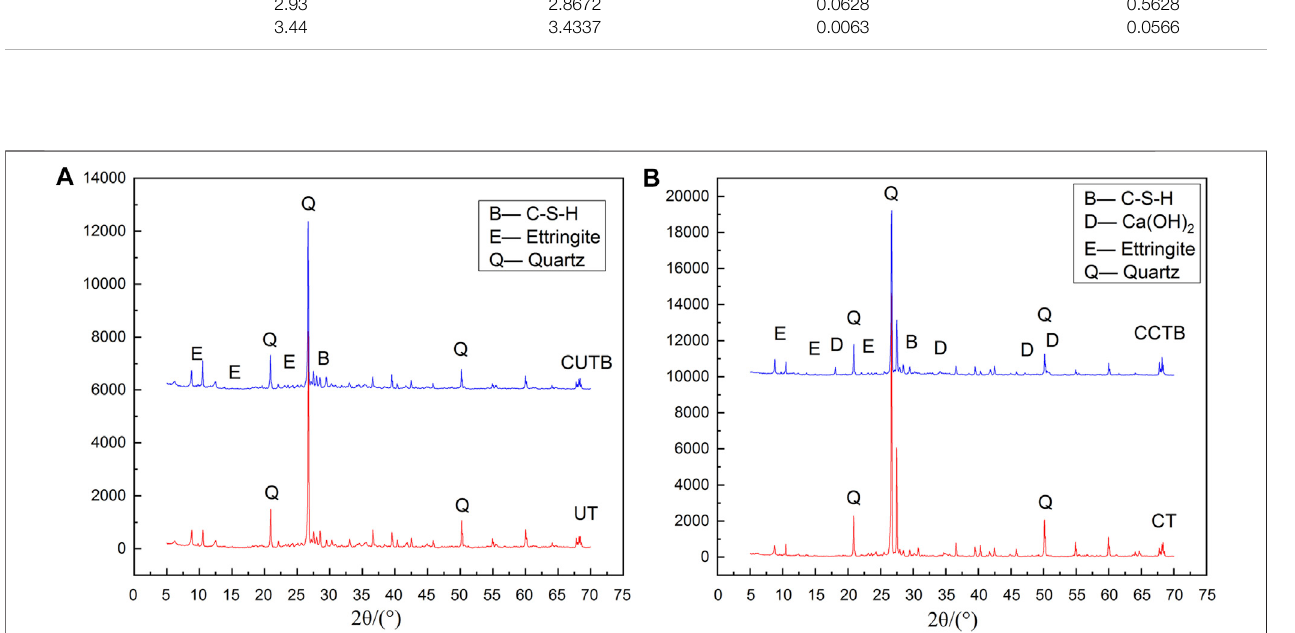
FIGURE 8 | XRD spectrum of CPB with S/W ratio 1:4 and curing age of 3 days: (A) CUTB; (B) CCTB.